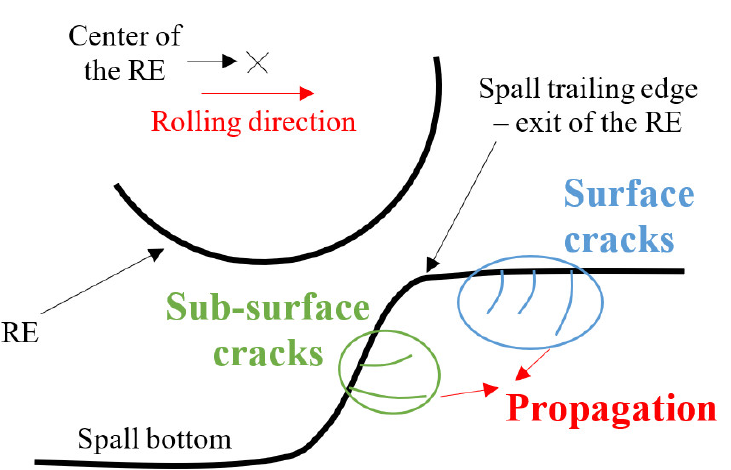
Figure 5. Schematic description of the fragment release from the spall edge, including the initiation of surface and sub-surface cracks. The cracks propagate until a fragment is released from the race- way.